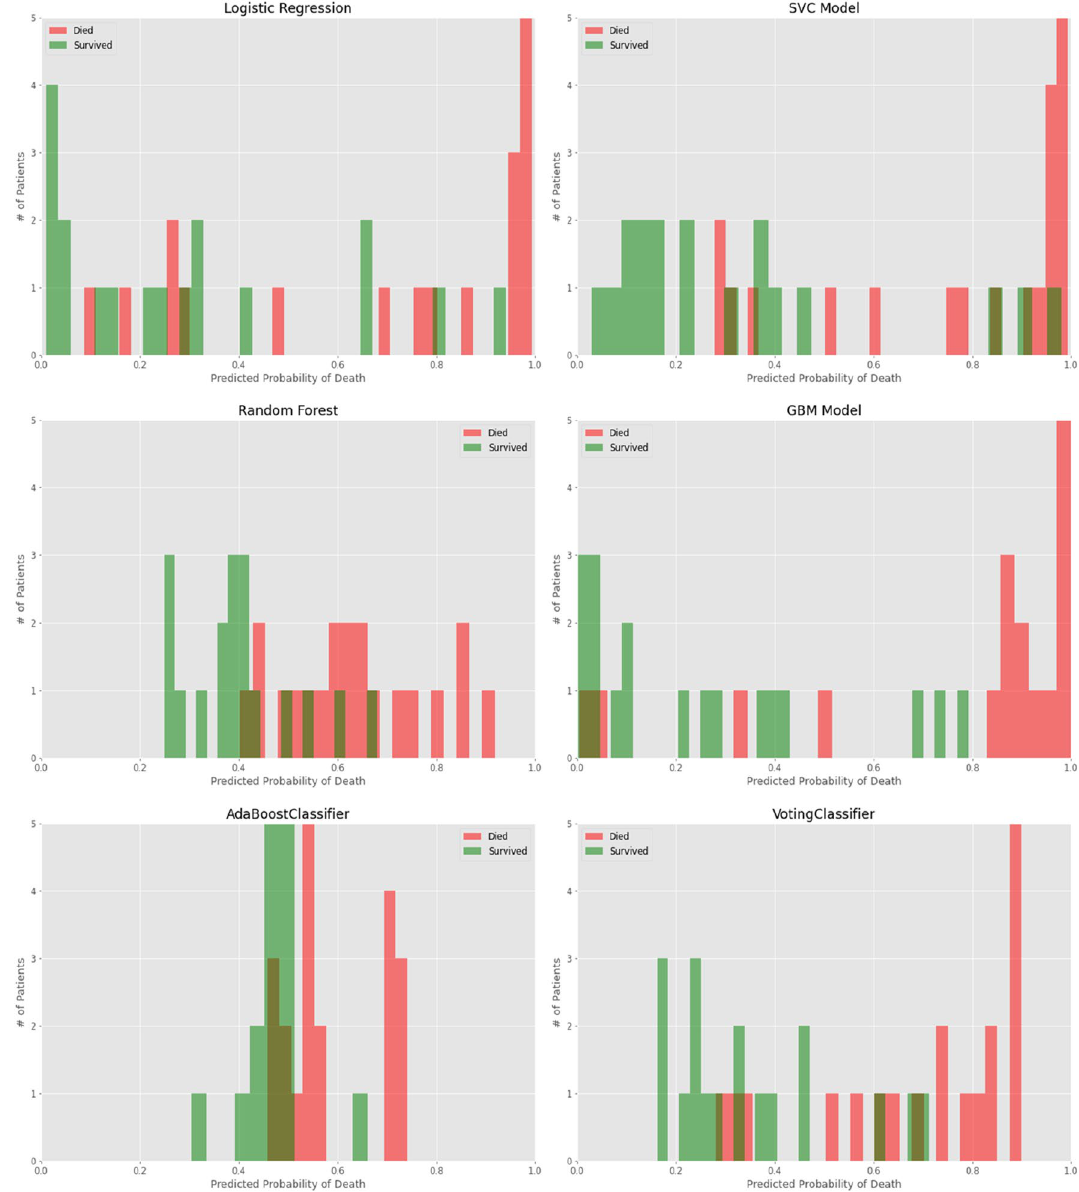
Figure 2. Probability curves for each ML model. Survivors indicated in green, and non-survivors in red. p < 0.005 for ensemble versus other